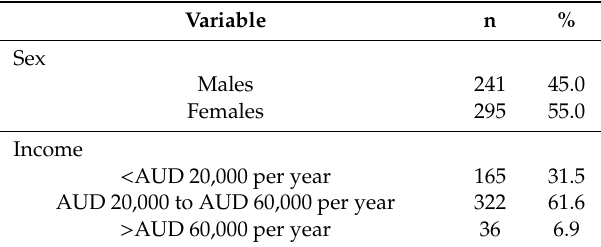
Table 2. Distribution of categorical